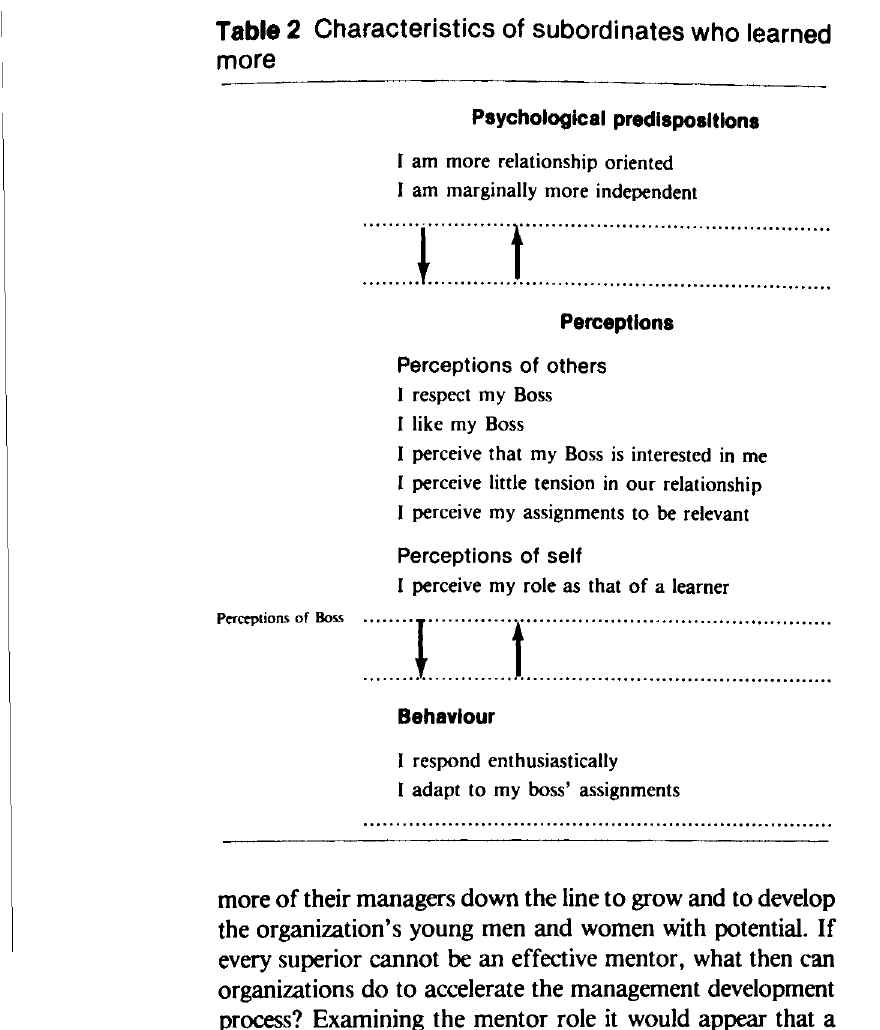
Table 2 Characteristics of subordinates who learned more